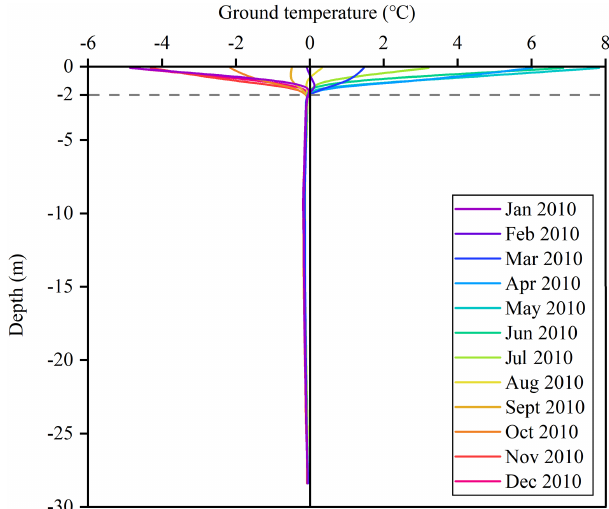
Figure 9. Ground temperature in the permafrost borehole drilled in 2010 at the Mahan